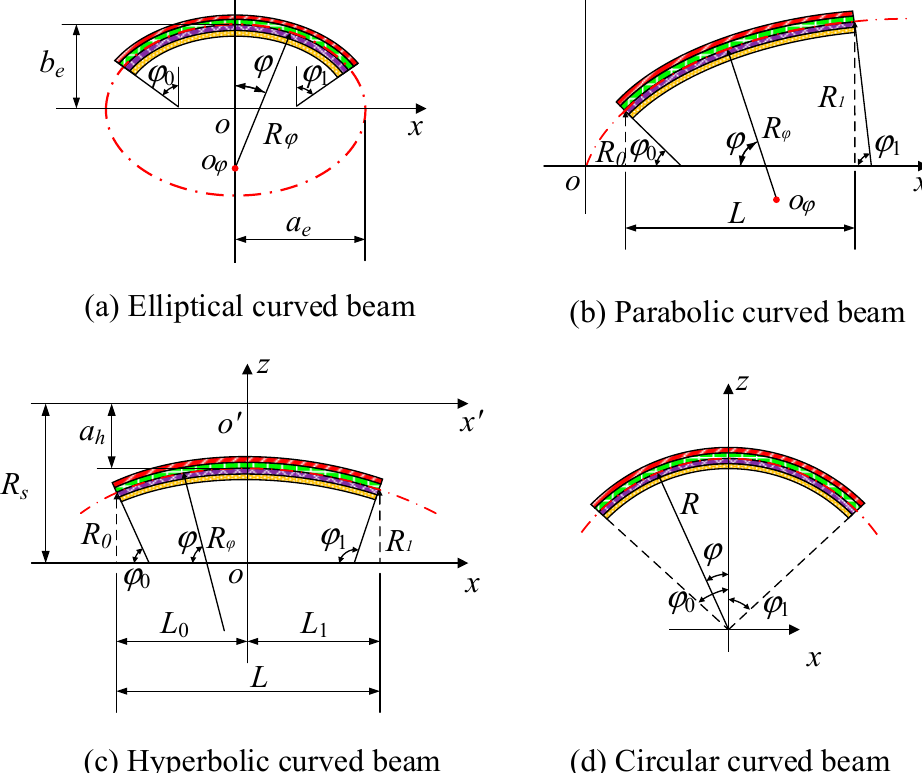
Figure 2. Different types of curved laminated composite beams (CLCBs): ( a ) Elliptic curved beam; ( b ) parabolic curved beam; ( c ) hyperbolic curved beam; ( d ) circular curved beam.